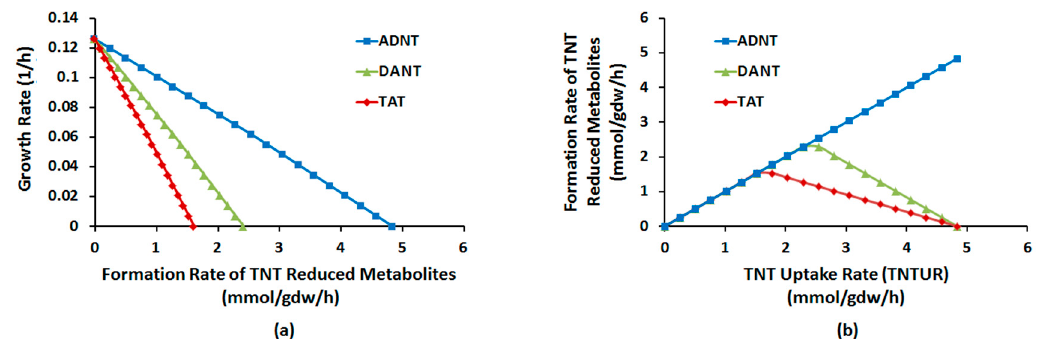
Figure 3. Robustness diagram: ( a ) optimal growth rate (GR) as function of fluxed through TNT (nitro)reduced metabolites; ( b ) optimal flux through TNT (nitro)reduced metabolites as a function of TNT uptake rate (TNTUR).